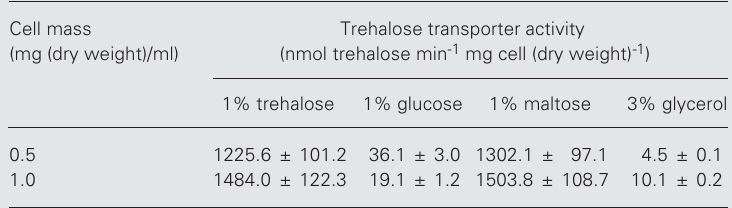
Table 1. Trehalose transporter activity of Candida utilis grown in media containing different carbon sources.